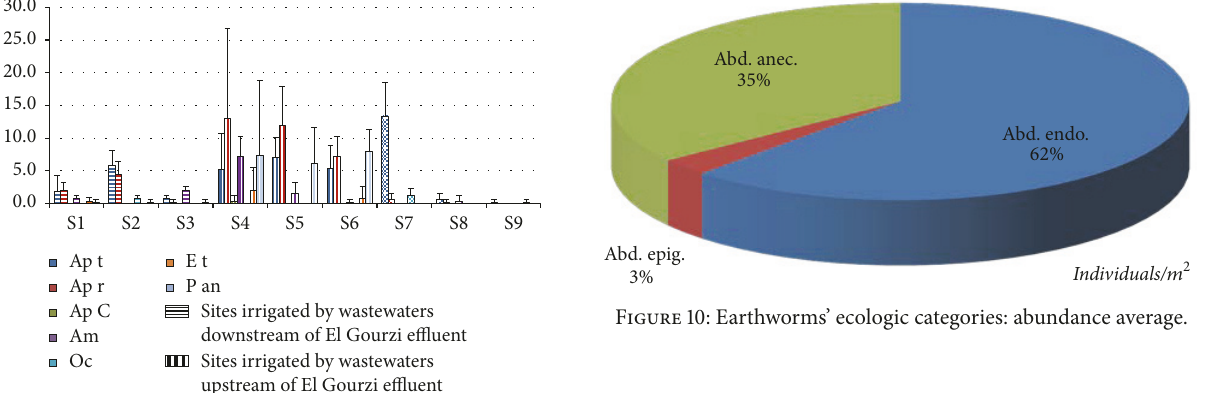
Abd. endo. Abd. epig. Abd.